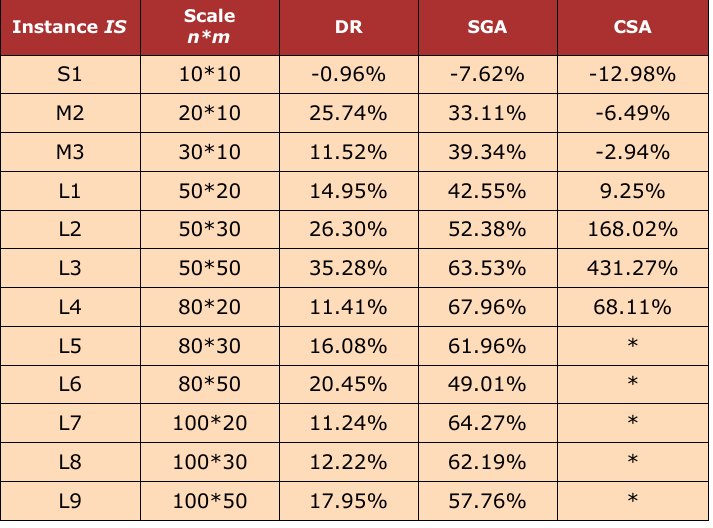
Table 2. The percentage of the value of DH-MB better than other methods ( δ